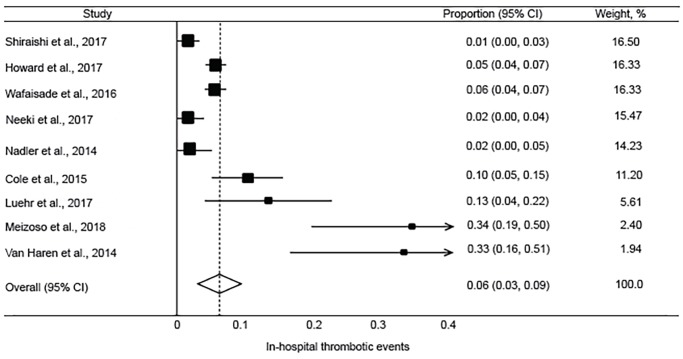
Forest plot of the incidence of in-hospital thrombotic events with tranexamic acid use in injured adults.CI, confidence interval.Chi-square=64.74 p<.0001; I2=87.6%.